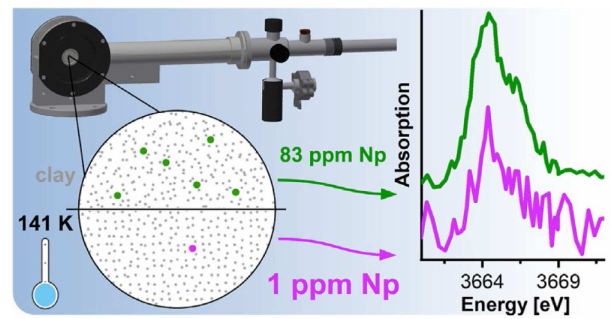
Fig. 5. Chemical zoning in Barite-Celestite solid solution crys- tallised diffusion controlled microfluidic experiment (modified after Poonoosamy et al.